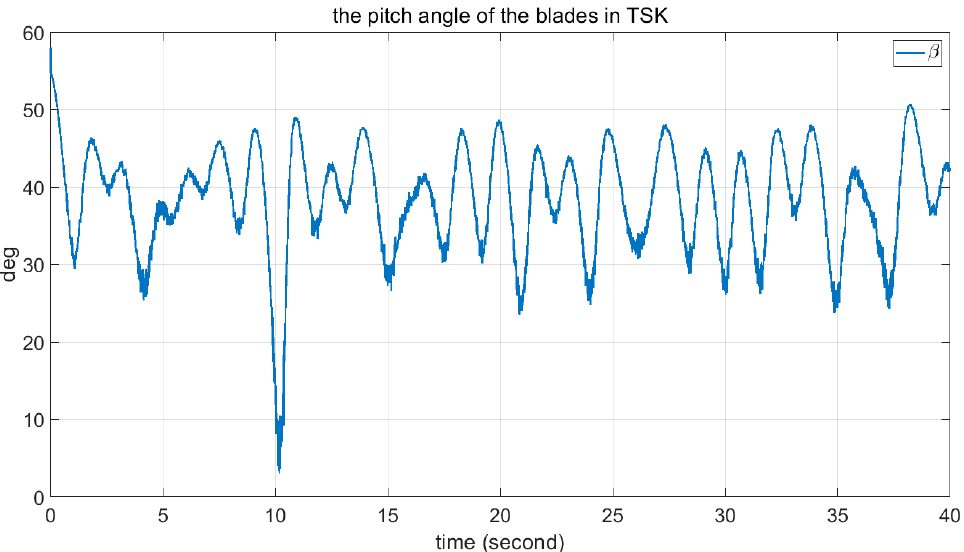
Figure 17. The input control signal of state feedback in fuzzy TSK.